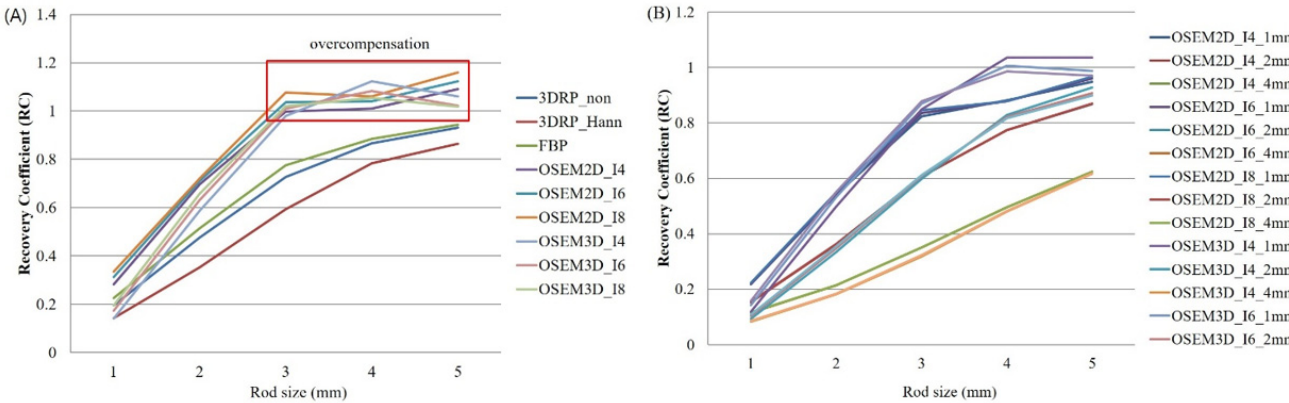
Figure 2. The RC values were obtained for five hot rods of the NEMA NU-4 mouse image quality phantom. ( A ) The RC values were overcompensated in iterative reconstruction methods (black lines). ( B ) The RC curve trend in the iterative reconstruction methods with 2 mm Gaussian filtering was similar to that in the FBP reconstruction (dotted lines).